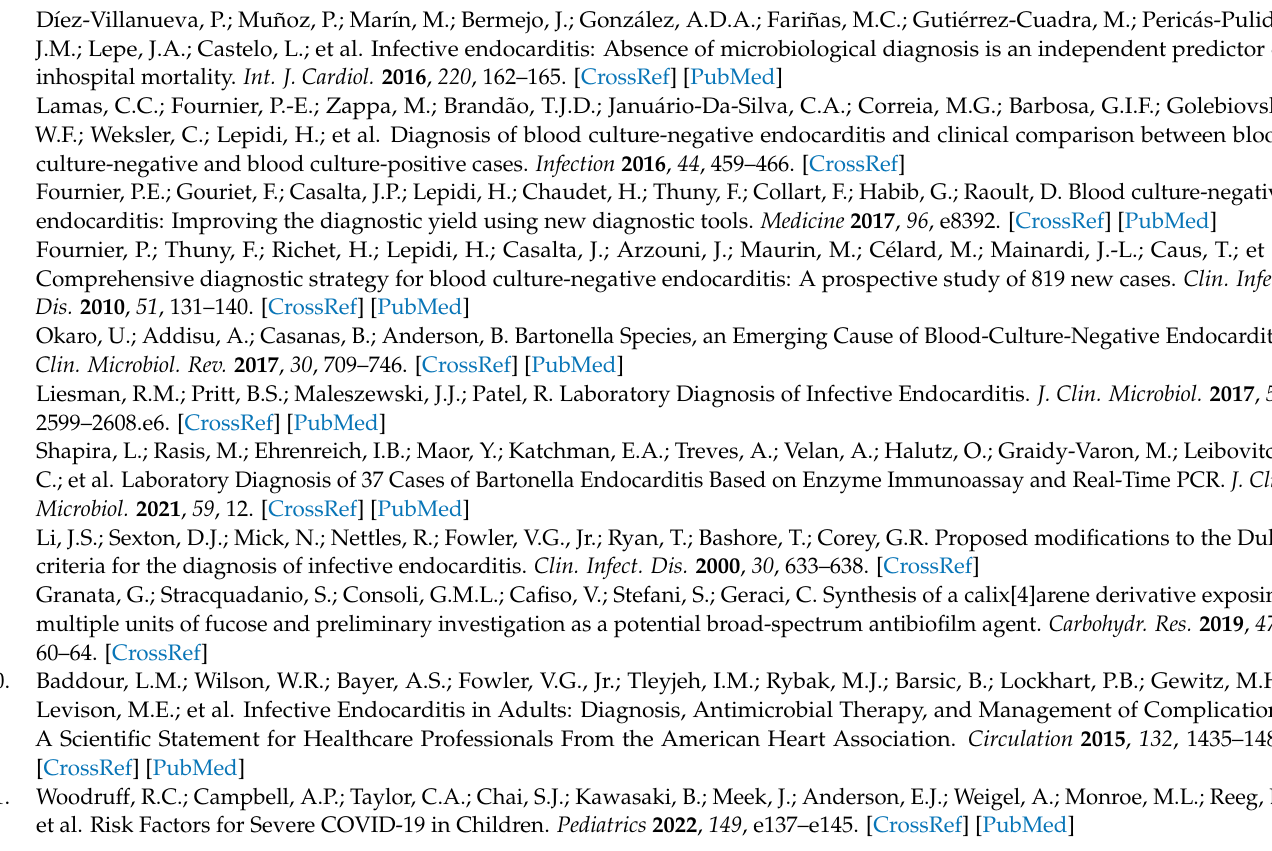
Table S2: Preoperative Transthoracic echocardiography or preoperative transesophageal echography; Table S3:Examniation of the pathogen; Table S4: Metagenomic next-generation (mNGS) summary in the 23